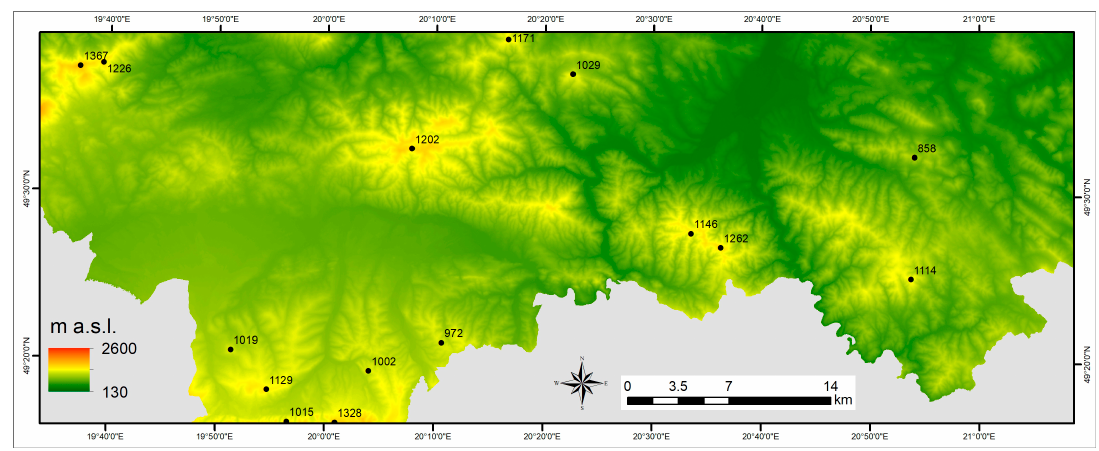
Figure 2. Shuttle Radar Topography Mission Digital Elevation Model (SRTM DEM) of the study area.